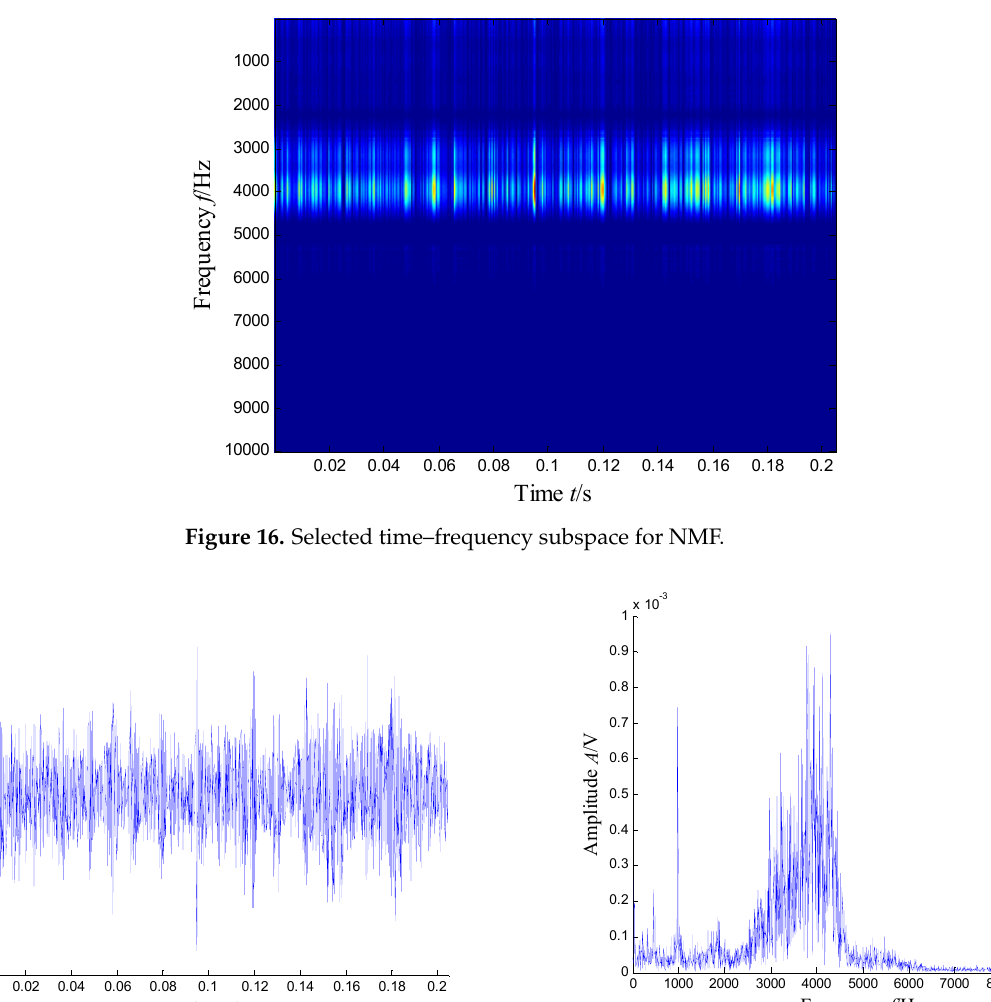
extracted signal. extracted